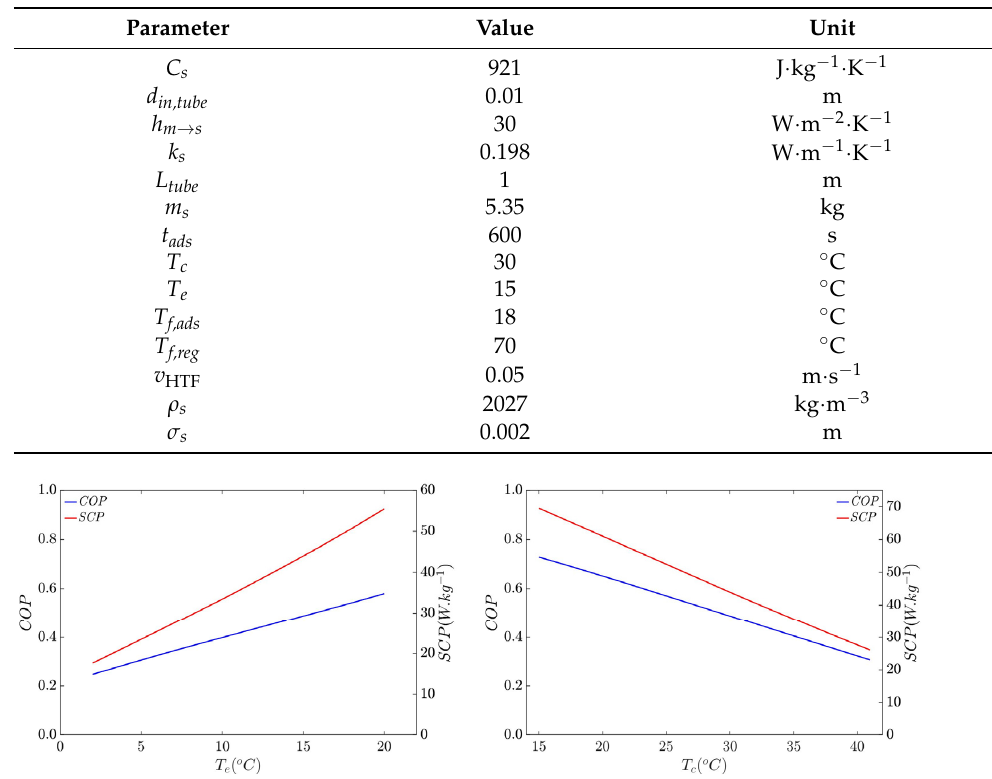
Table 1. Reference parameters used to calculate the COP and SCP. Parameter